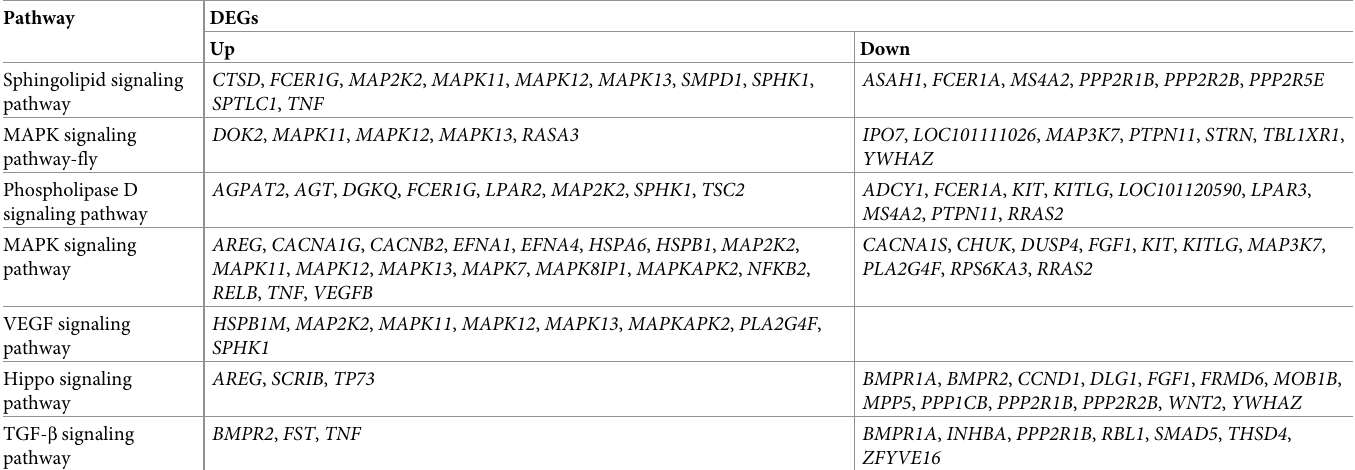
Table 3. The DEGs enriched the pathways related to environmental information